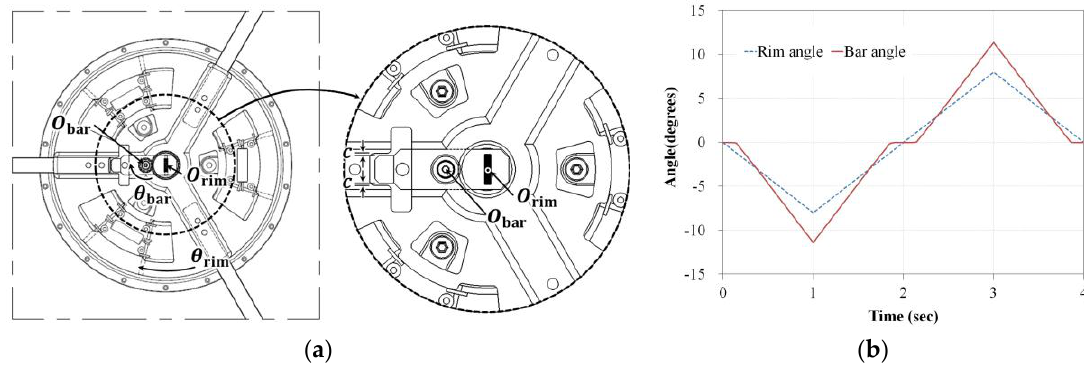
Figure 3. ( a ) Shape of movement of the bar and ( b ) simulation results of the rim and bar